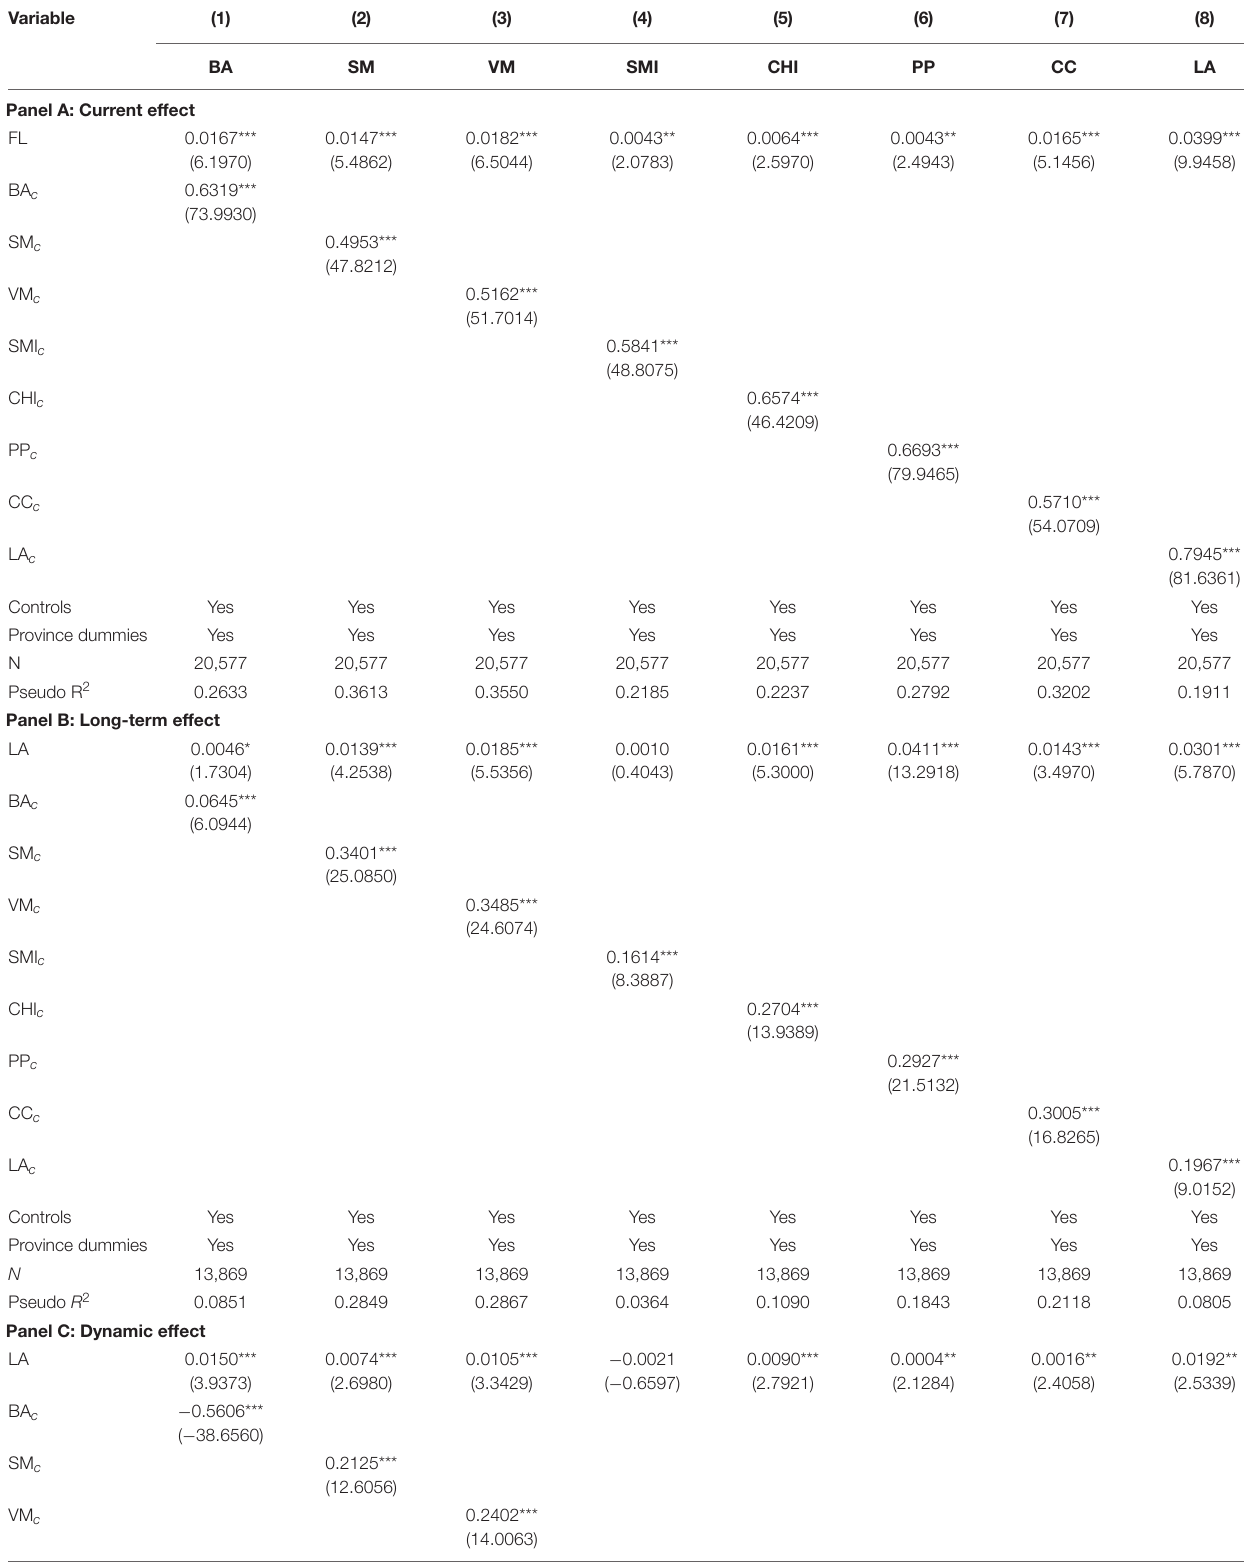
TABLE 11 | Robust test by controlling the effect of community peer